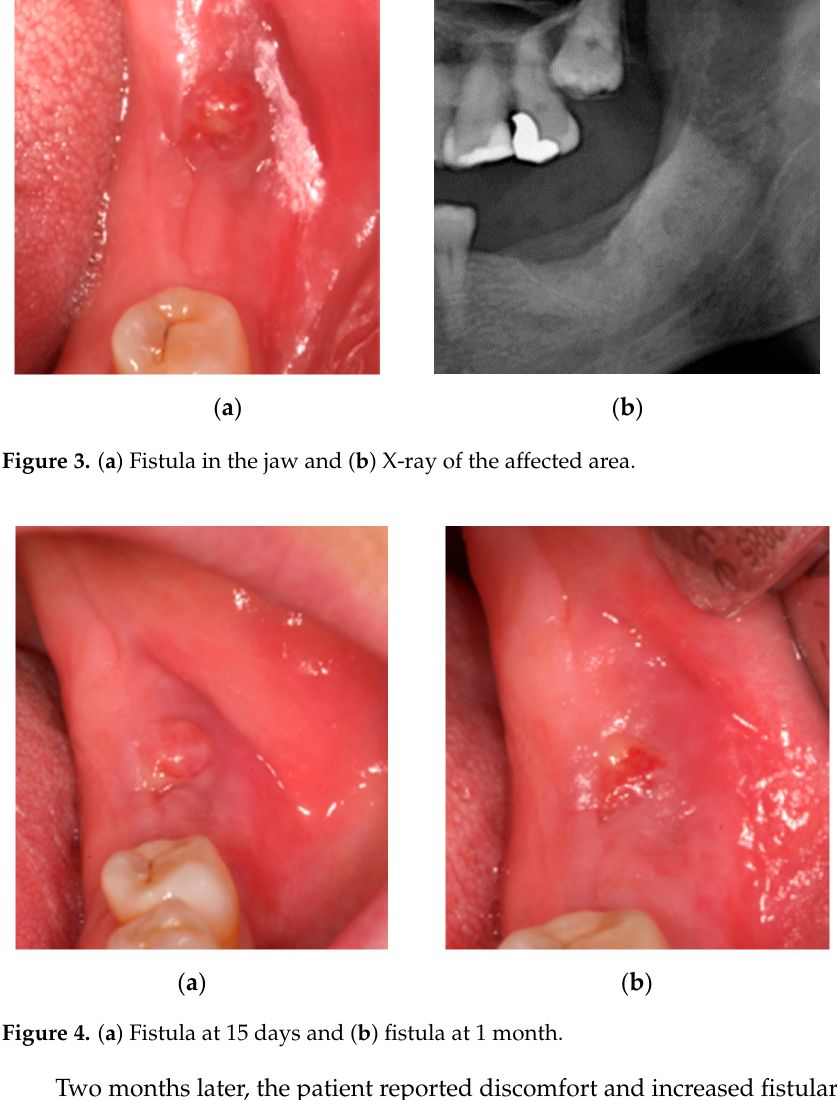
Figure 4. ( a ) Fistula at 15 days and ( b ) fistula at 1 month. Two months later, the patient reported discomfort and increased fistular suppuration, but without bone exposure. After re-establishing conservative treatment with amoxi- cillin/clavulanic acid (2000 mg + 125 mg every 12 h for 15 days) (Augmentin Plus, GSK, Madrid, Spain) and 0.12% chlorhexidine rinses (Perio-Aid, Dentaid, Barcelona, Spain) every 12 h for 30 days, minimal surgery for the removal of necrotic bone tissue was decided upon. After local anesthesia with articaine 4% + epinephrine (Inibsa, Barcelona, Spain), a flap was made at full thickness without discharges, necrotic bone tissue was removed, and smooth curettage of the bone walls with a dental spoon was made until bleeding was produced. The surgical bed was irrigated with serum and 0.12% chlorhexidine (Perio-Aid, Dentaid, Barcelona, Spain). The wound was stitched with 7/0 non-resorbable monofilament (Sera- lene, SERAG Wiessner Iberia, Madrid, Spain) (Figure